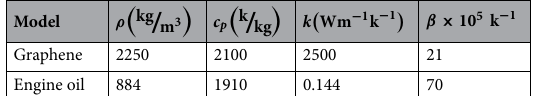
Table 1. Properties of nano particles.